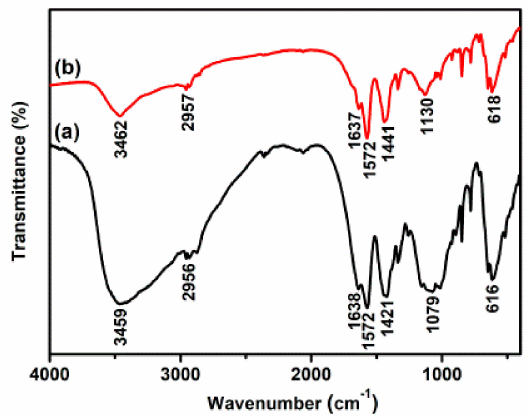
Figure 2. FT-IR spectra of ( a ) chitosan and ( b ) N-CQDs.